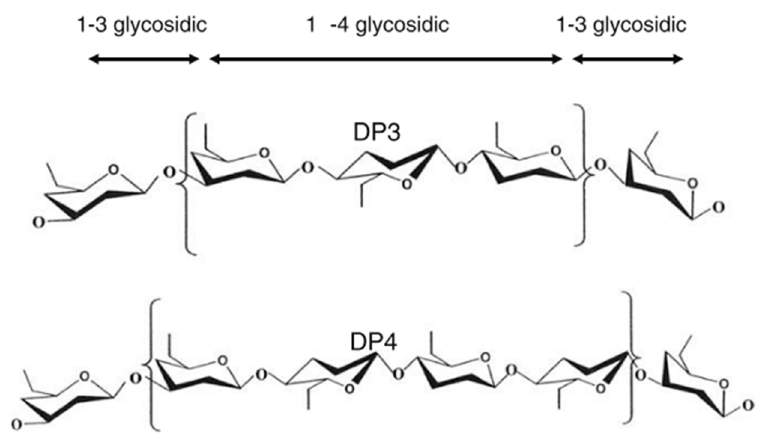
Figure 3. Molecular structure of cereal β -glucan [68].